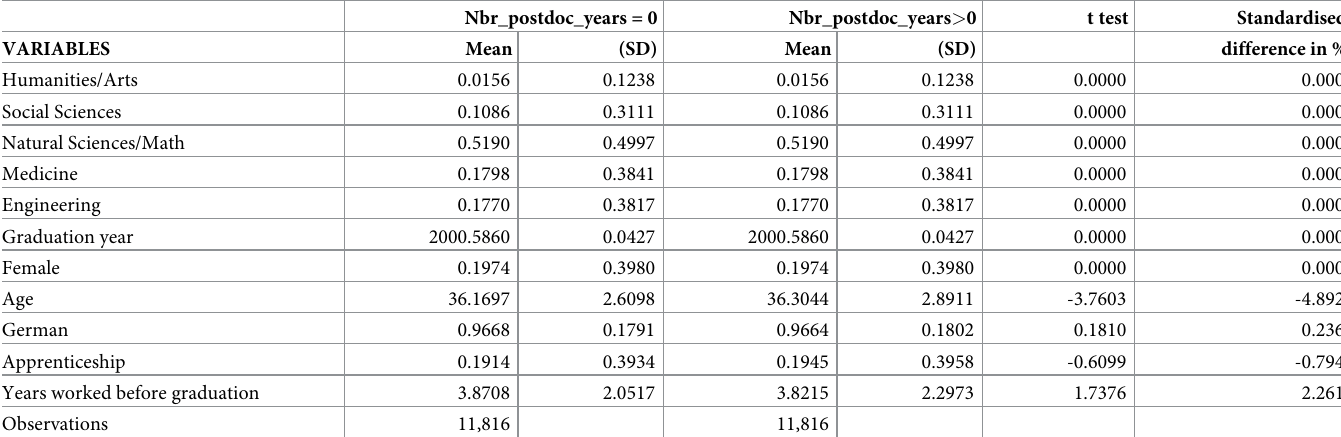
Table 1. Descriptive statistics of matching